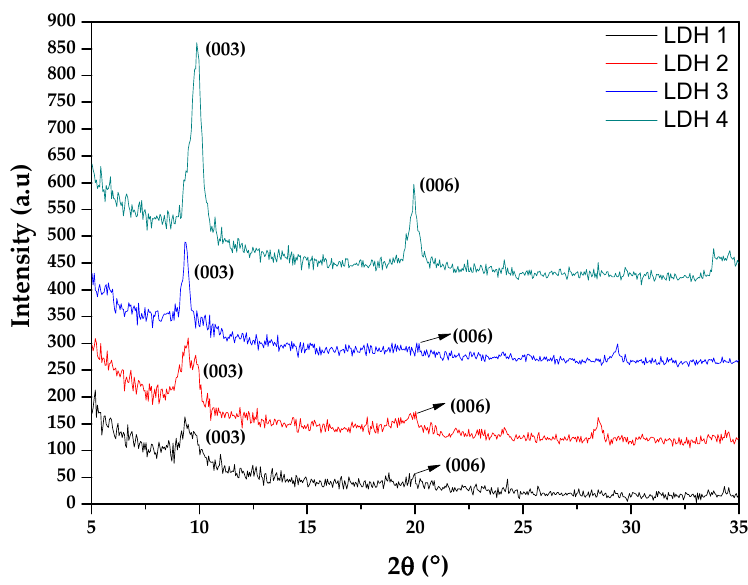
Figure 4. XRD patterns of Zn-Al-LDH-coated AA1050 alloy at different conditions.